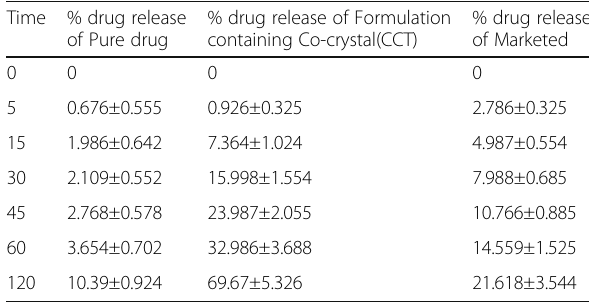
Table 9 The drug release profile of Pure FNO, Formulation containing co-crystal (CCT) and Marketed formulation